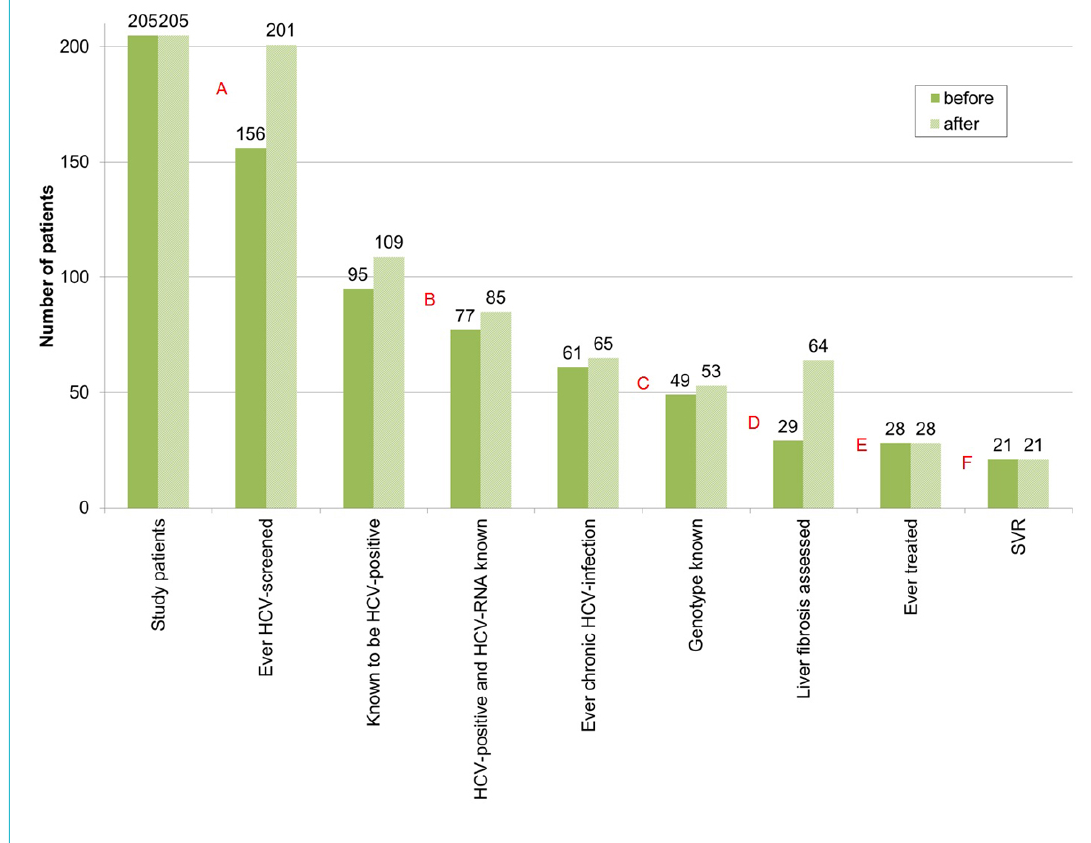
Figure 2: Diagnostic and treatment-related gaps in the HCV cascade (total study population), before and after HCV rapid tests and Fi- broscan ® within our study.HCV = hepatitis C virus; SVR = sustained virological response; before = before HCV rapid tests and Fibroscan ® within our study; after = after HCV–rapid tests and Fibroscan ® within our studyA = first diagnostic gap – no HCV antibody screening: 23.9% (49/205) → 2.0% (2/205); B = second diagnostic gap – no HCV RNA determination, if HCV positive: 18.9% (18/95) → 22% (24/109); C = third diagnostic gap – HCV genotype unknown, if ever chronic HCV infection: 19.7% (12/61) → 18.5% (12/65); D = fourth diagnostic gap – no liver fibrosis assessment, if ever chronic HCV infection: 52.5% (32/61) → 1.5% (1/65). E = treatment uptake gap – never treated, if ever chronic HCV infection: 54.1% (33/61) → 56.9% (37/65). F = treatment success gap – treated, but no sustained virological response: 25.0% (7/28) → 25.0%